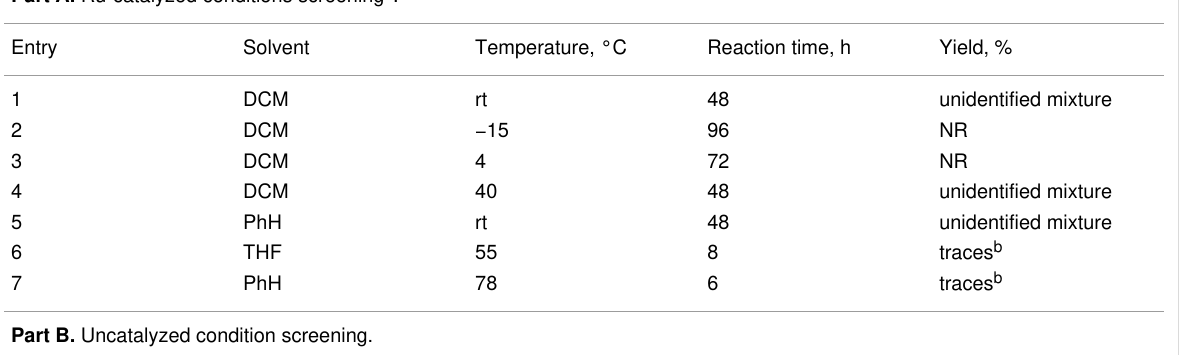
Part A. Ru-catalyzed conditions screening a